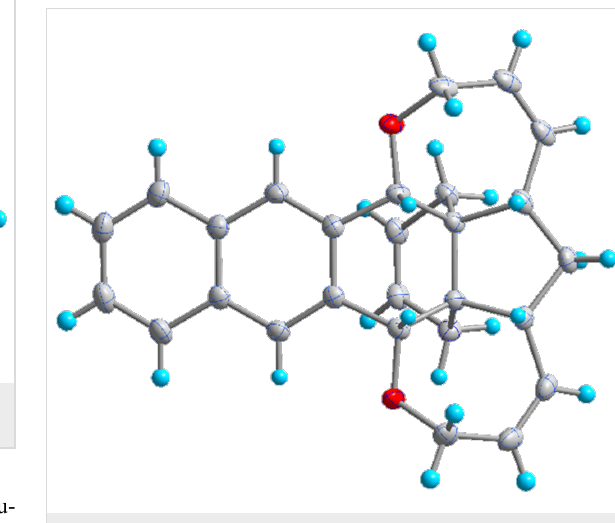
Figure 3: Crystal structure of compound 15 showing 50% displace- ment